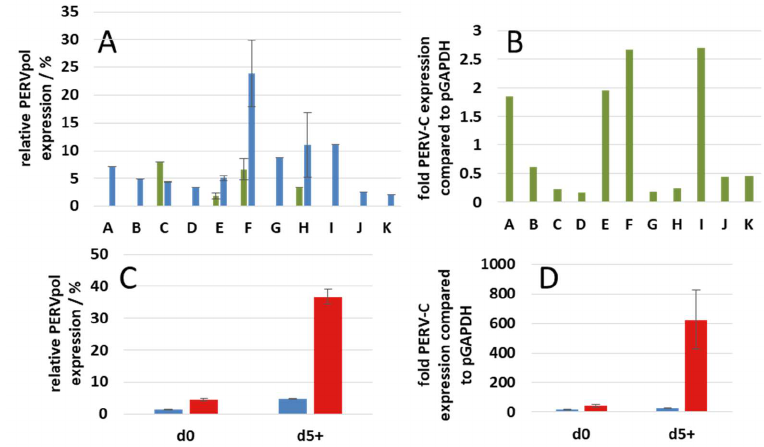
Figure 7. Relative expression of all PERVs using primers specific for pol ( A , C ) and primers specific for PERV-C env ( B , D ). ( A ), Expression of PERVpol at day zero (green column) and day 5 after PHA stimulation (blue columns) relative to the expression in PK15 cells. Eleven pigs (A, B, C, D, E, F, G H, I, J and K) were tested. PBMCs from pigs A, B, D, G, I, J and K were tested once, the PBMCs from pigs C and H were tested twice (two bleedings with independent PHA-L stimulations), the PBMCs from pigs E and F six times (three different bleedings with independent PHA-L stimulations). In the case of pigs A, B, D, G, I, J, and K no measurement at day 0 were performed. ( B ), expression of PERV-C at day 0 compared to the expression of GAPDH, ( C ), relative expression of PERVpol compared with the expression of PK15 cells on day 0 (d0) and day 5 (d5) after stimulation with PHA (PBMCs from animal E, blue column, PBMCs from animal F, red column), ( D ), expression of PERV-C on day 0 (d0) and day 5 (d5) after stimulation with PHA-L compared to the expression of GAPDH (PBMCs from pig E, blue column, PBMCs from pig F, red column). All error bars indicate s.e.m. Table 3. Expression of PERV in stimulated and unstimulated PBMCs from GöMP.